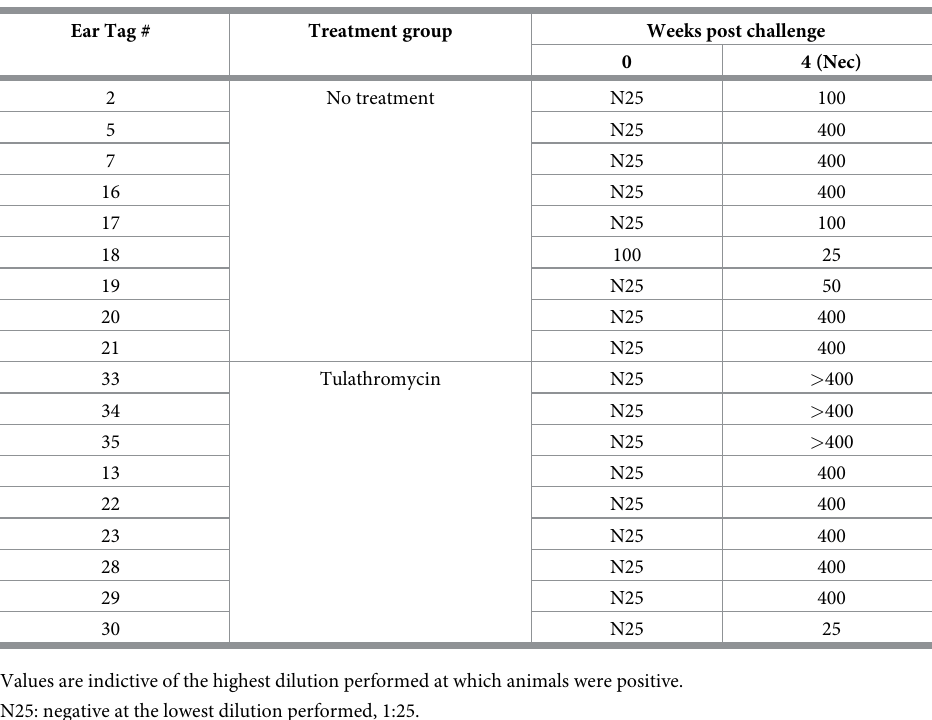
Table 2. Standard agglutination tube data for pregnant goats prior to and post- B . melitensis 16M challenge. Ear Tag # Treatment group Weeks post challenge